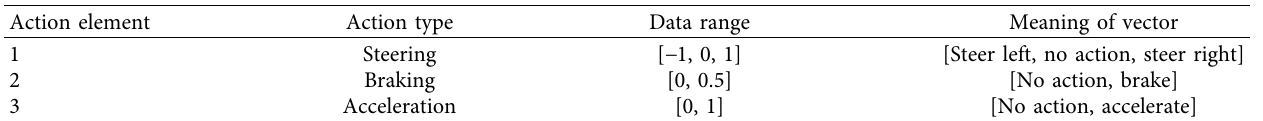
Figure 4: Lane width modifcation. (a) Original lane width. (b) Modifed lane width to 3.75m. Table 3: Action